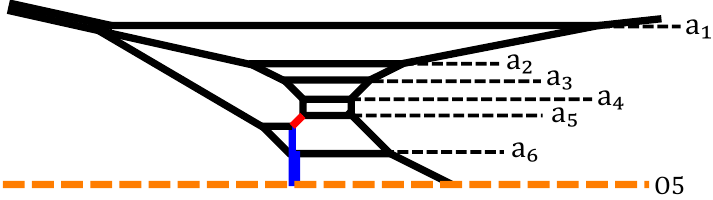
Figure 2 . A 5-brane diagram realizing the SO(12) gauge theory with a conjugate spinor which is obtained after performing a generalized (cid:13)op transition to the diagram in (cid:12)gure 1. (cid:12)rst label the height of the six color D5-branes as a